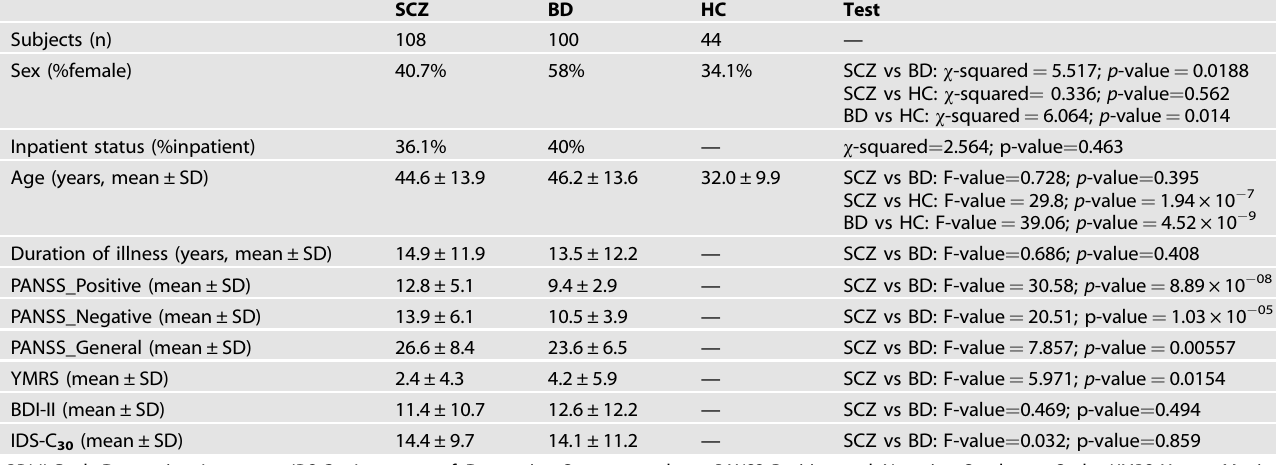
Table 1. Demographic and psychopathological data of study participants.